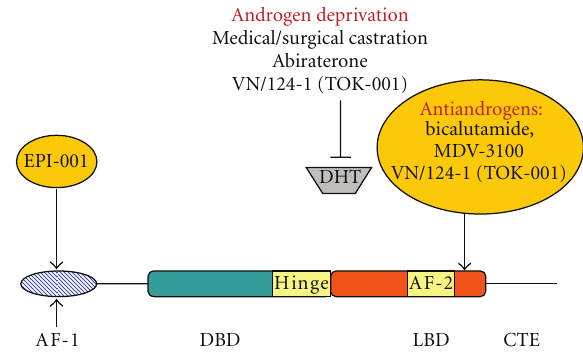
Figure 2: Therapeutic approaches to block the AR. EPI-001 interacts with the AR NTD to block AR transcriptional activity through this domain. Inhibitors of the LBD include androgen ablation and antiandrogens, DHT, and